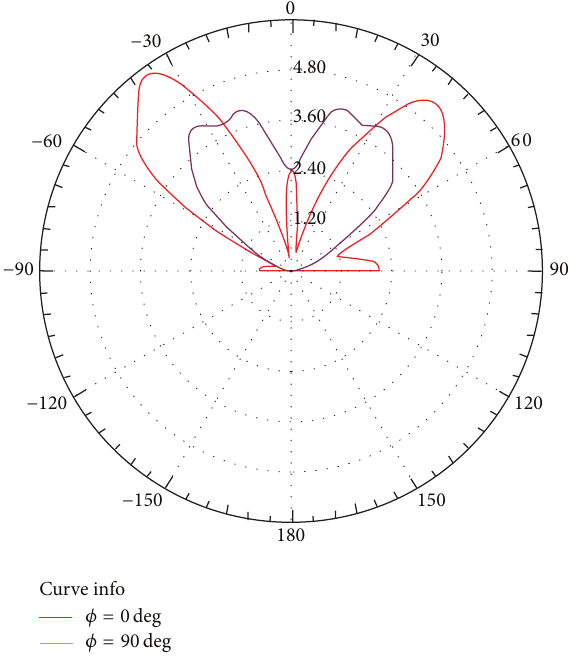
2 D gain versus 𝜃